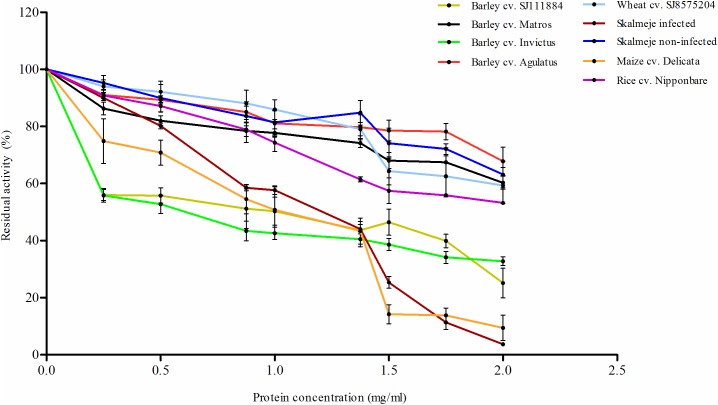
The effect of increasing concentrations of crude protein extracts of representatives of cereal species on the activity of A. ficuum phytase.Different cultivars of cereal species are represented with different coloured solid lines. Results are averages of three replicates and the differences among replicates are indicated with error bars. 100% residual activity is equivalent to 2.5 Uml-1 activity.